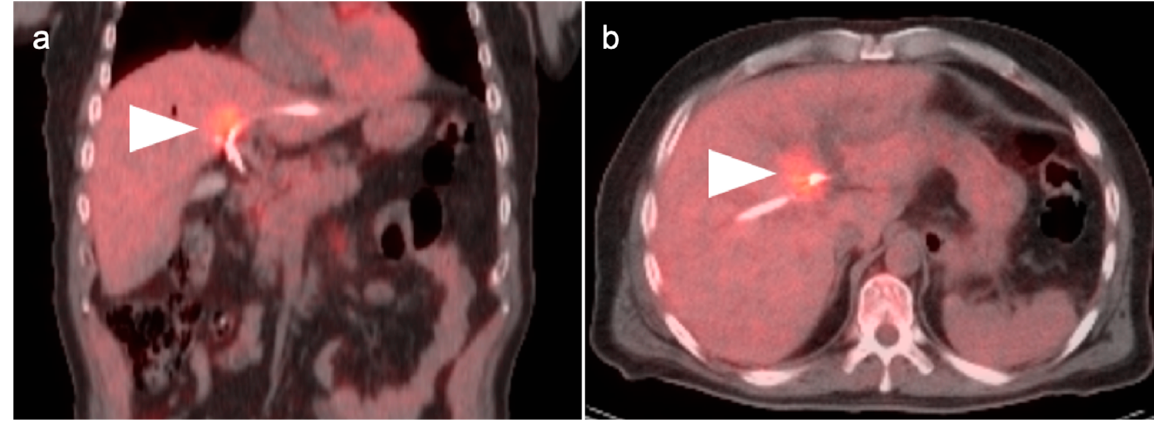
Figure 19. Hilar cholangiocarcinoma (Klatskin tumor). The tumor at the hepatic hilum is moderately hypermetabolic (white arrowheads) on fused FDG PET-CT shown in coronal ( a ) and axial ( b ) projections, which required placement of biliary drainage tubes.